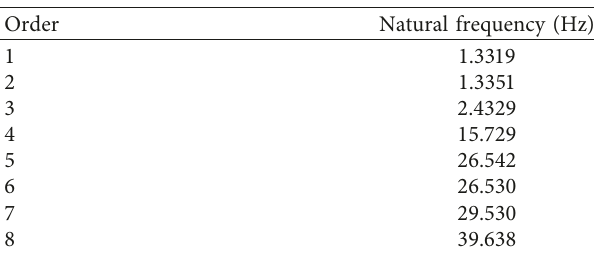
Figure 11: Order mode of the buffering device: (a) first-order mode shape; (b) second-order mode shape; (c) third-order mode shape; (d) fourth-order mode shape; (e) fifth-order mode shape; (f) sixth-order mode shape; (g) seventh-order mode shape; (h) eighth-order mode shape. Table 1: Order mode of the buffering device.